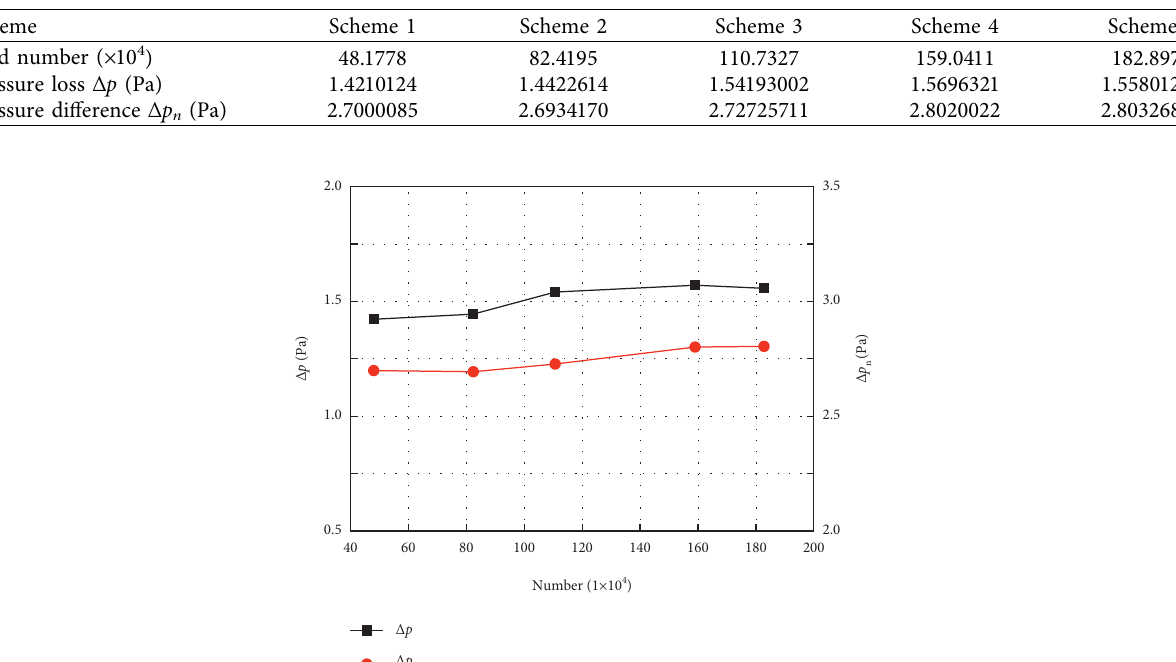
Figure 7: Flow field and rotor structure grid of flowmeter. (a) The whole flow field. (b) Cross-section grid in flow field. (c) Solid field domain grid. Table 1: Grid information of flow field domain.